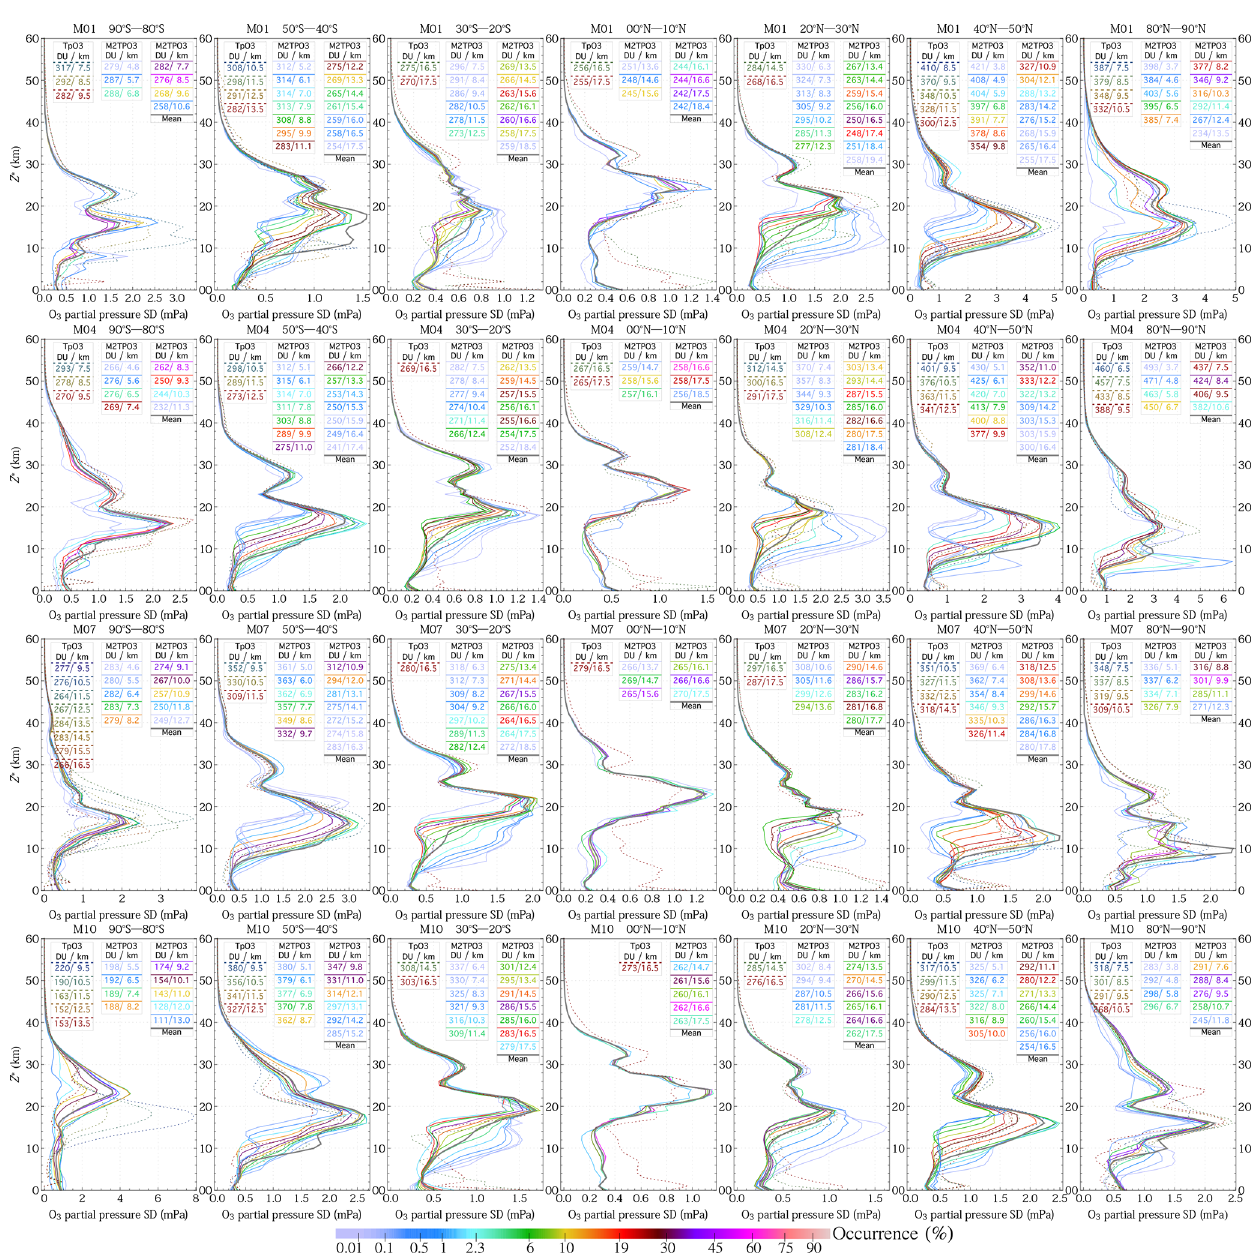
Figure 5. Similar to Fig. 4, but for standard deviation (SD) comparisons between M2TPO3 and TPO3 of Sofieva et al.